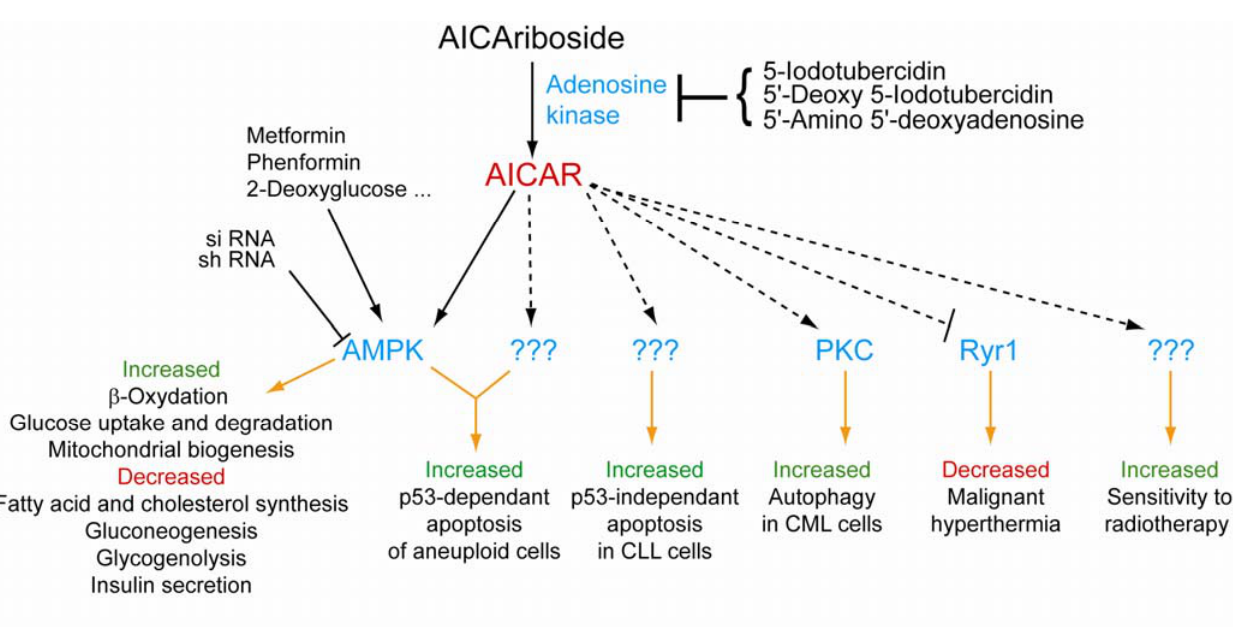
Figure 3. Schematic depiction of AICAR cellular targets and associated biological effects. CML: Chronic myeloid leukemia. CLL: Chronic lymphocytic leukemia. PKC: Protein kinase C. Ryr1: Ryanodine receptor 1. All targets and biological effects presented are described in